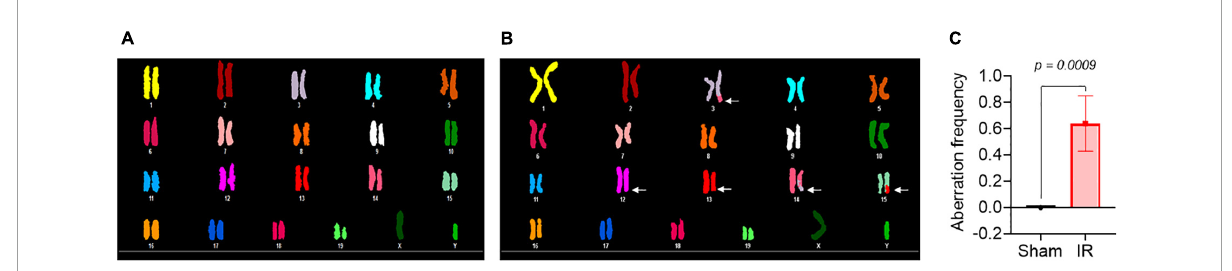
FIGURE5 Representative photomicrographs of chromosomes following spectral karyotyping (SKY) hybridization in (A) sham-irradiated and (B) irradiated mice (arrows indicate breaks and translocations). (C) Aberration frequency in sham-irradiated ( n = 4) and irradiated ( n = 4) mice as estimated by observing change in length or color junction. Statistical uncertainty between the groups was determined by t -test.